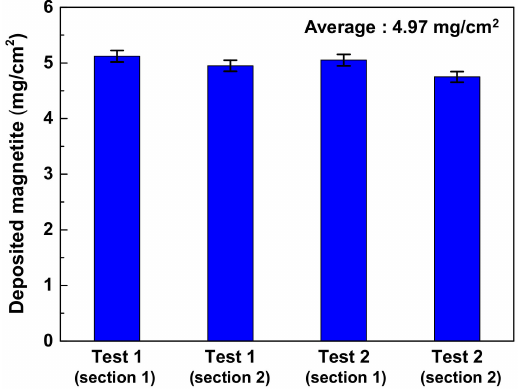
Figure 12. Amount of magnetite deposited onto Alloy 690TT